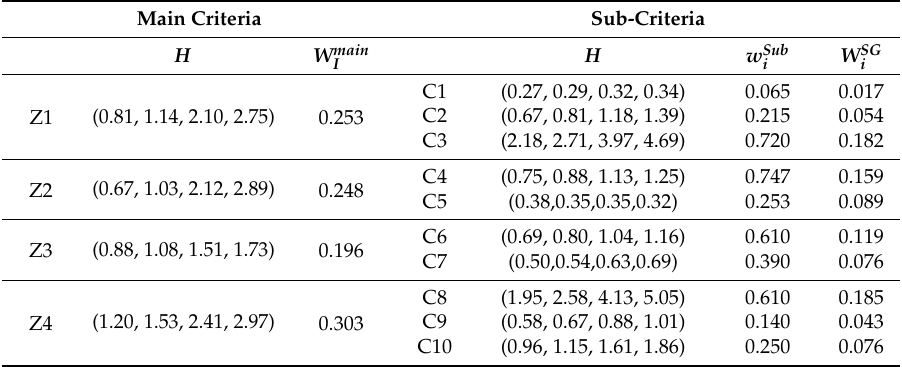
Table 12. Fuzzy aggregated extent values and evaluation criteria